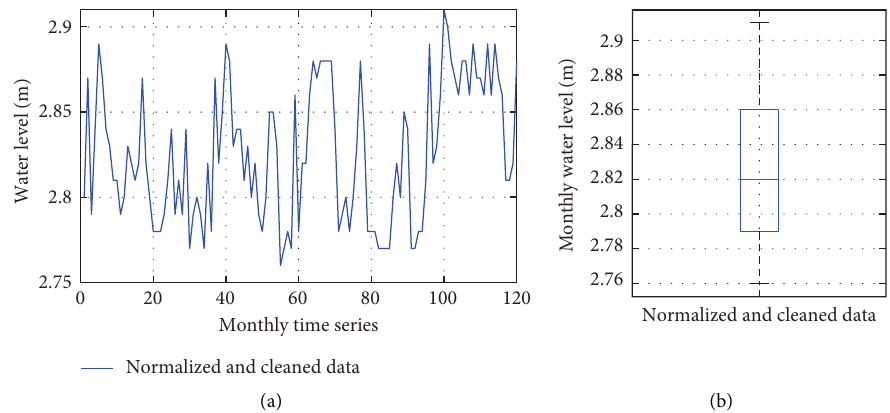
Figure 4: (a) Monthly time series and (b) box plot of normalized and cleaned water level